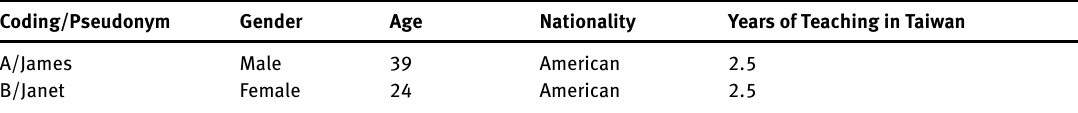
Table 2: Background information of participants (compiled by the author)